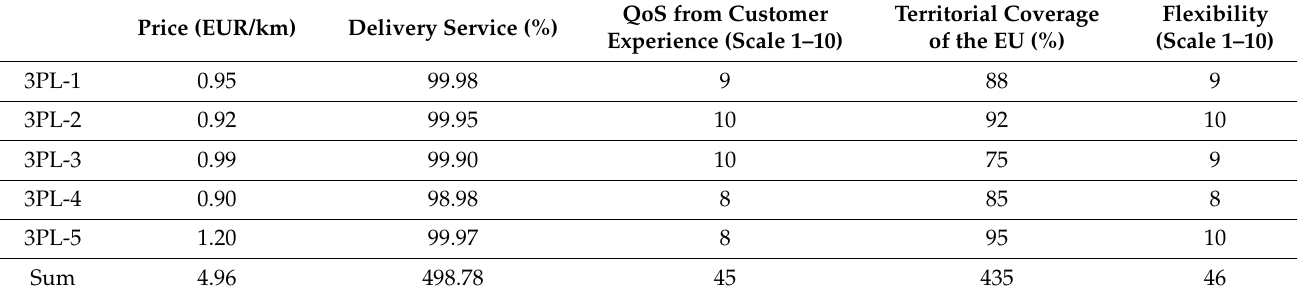
Table 3. Initial entropy decision-making matrix (Source: Authors).